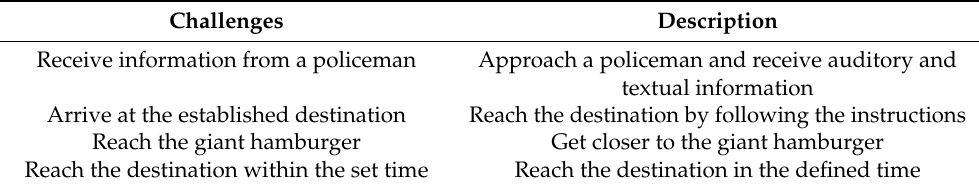
Table 5. Challenges implemented in the “Street Simulator” game.